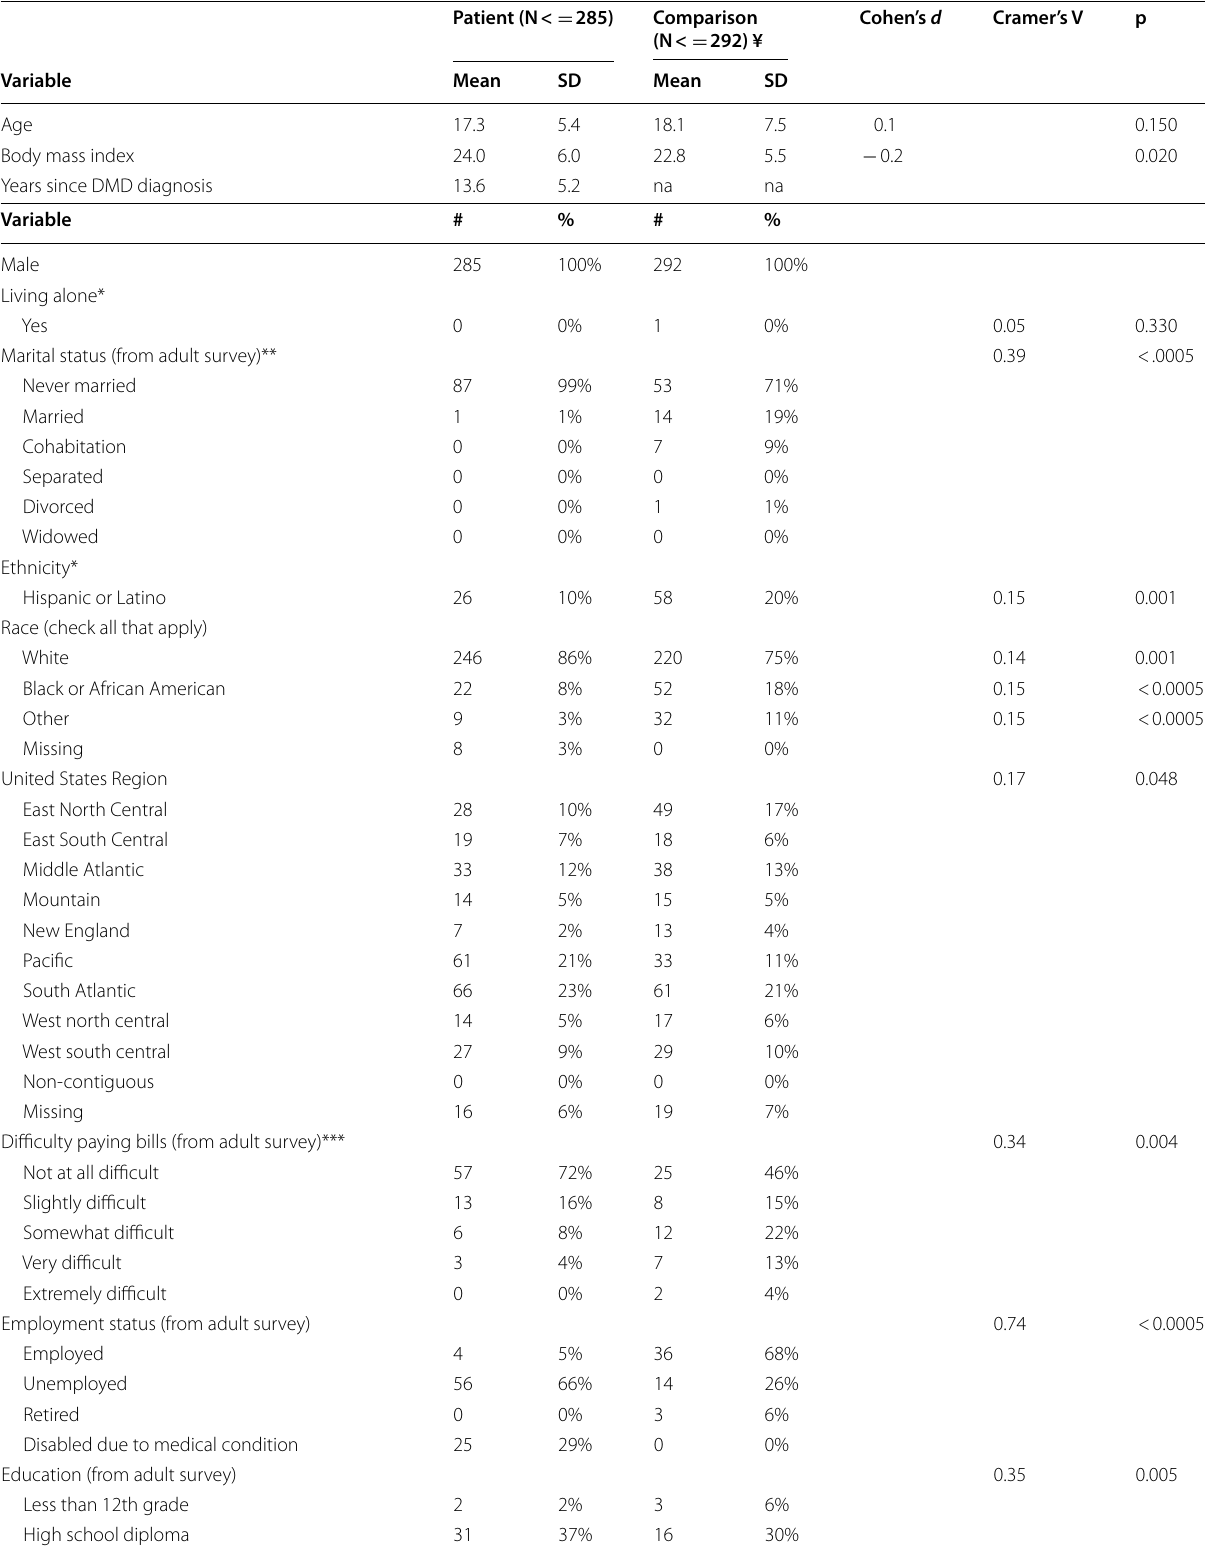
Table 1 Sample demographic characteristics (N